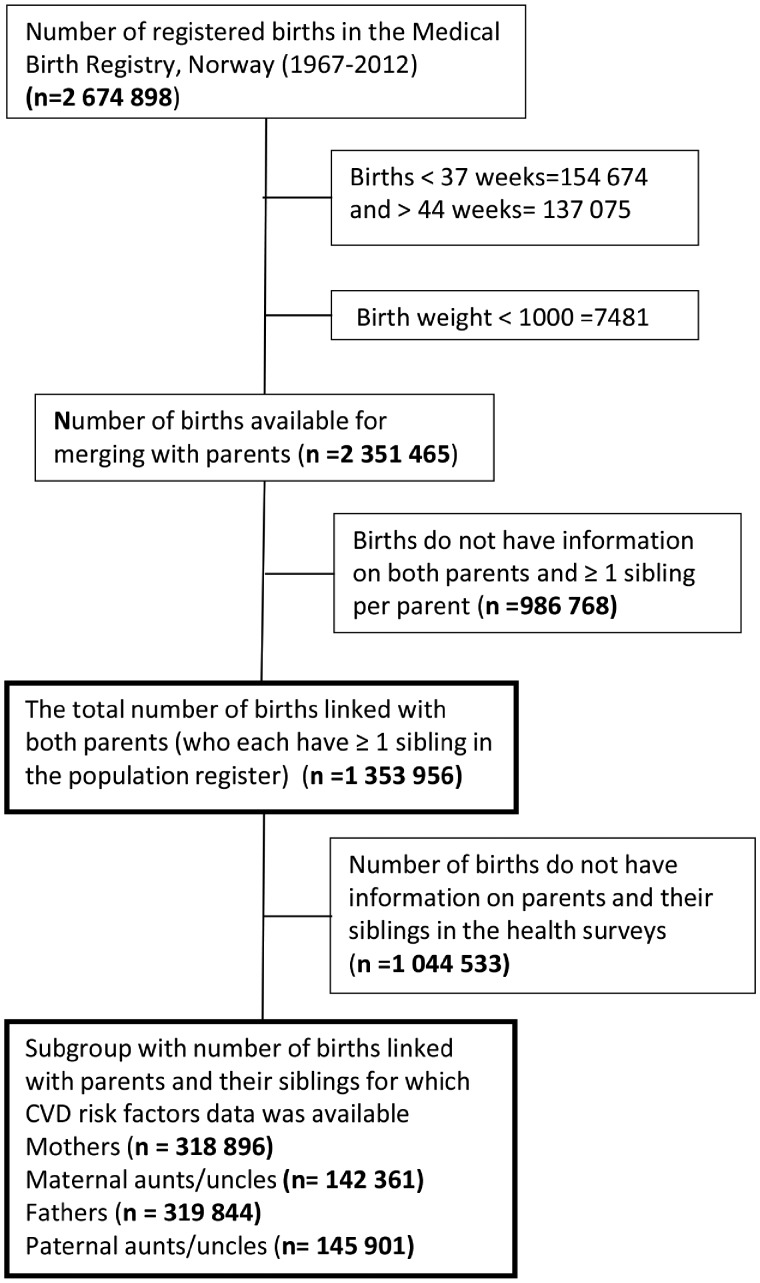
Flow chart of the study population.